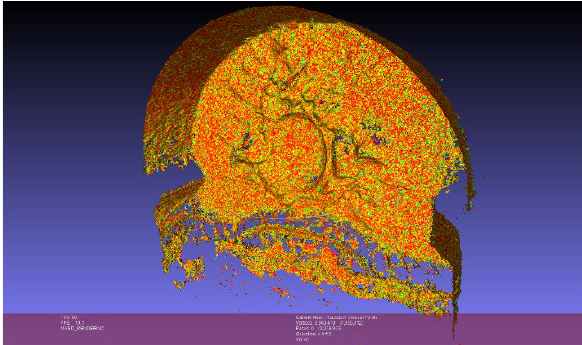
Figure 6. Check error simplification by calculating the Haursdorff distance. Detail of the apse 5. PROJECTION / PERCEPTION